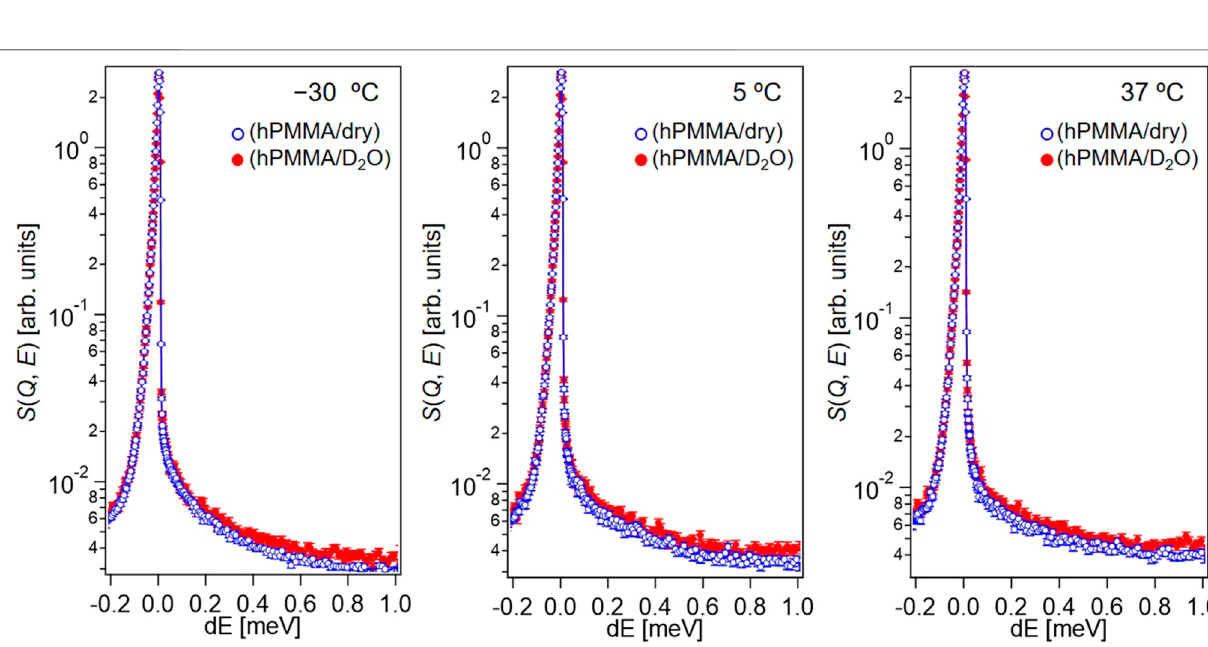
Frontiers in Chemistry |